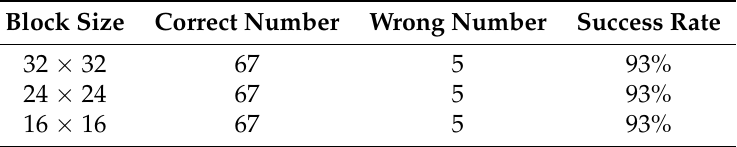
Table 1. The test result of block size.